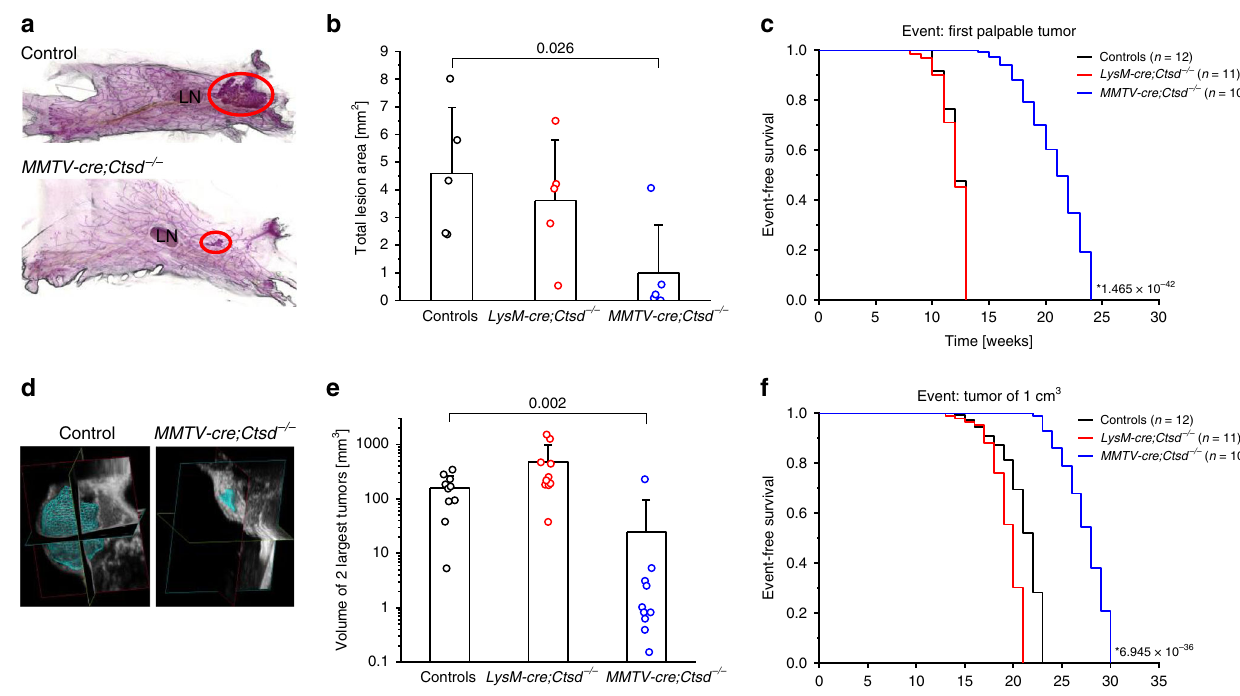
Fig. 1 Mammary epithelium-speci fi c CTSD de fi ciency delays tumor development in PyMT mice. a Representative pictures of whole mounts of mammary glands from 8-week-old PyMT mice of indicated genotypes (Control: Ctsd fl / fl ). Areas occupied by dysplastic lesions are encircled in red and quanti fi ed in b ( n = 5 animals; two-sided two-sample t-test). LN, lymph node. c Kaplan – Meier analysis for fi rst palpable tumors in PyMT mice of indicated